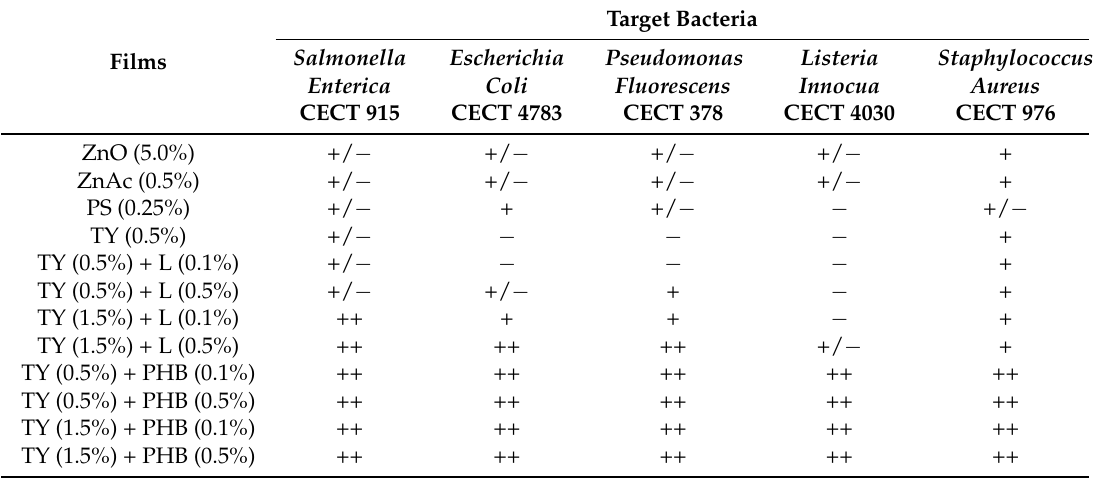
Table 1. Inhibition zones obtained by plastic films activated with different antimicrobials.